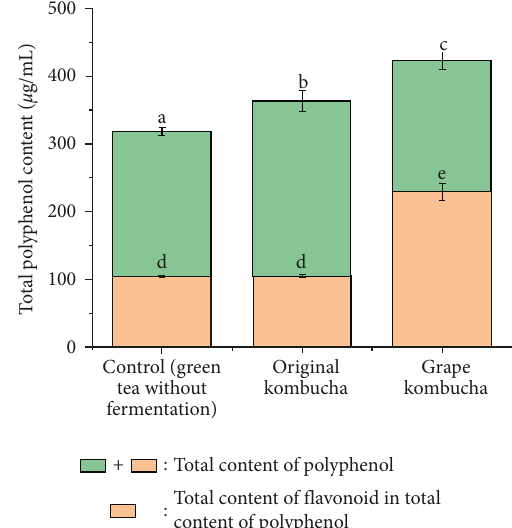
Figure 4: Total polyphenol and flavonoid in green tea without fermentation (control), original green tea kombucha, and grape kombucha. Different letters indicate significant difference ( P < 0 .